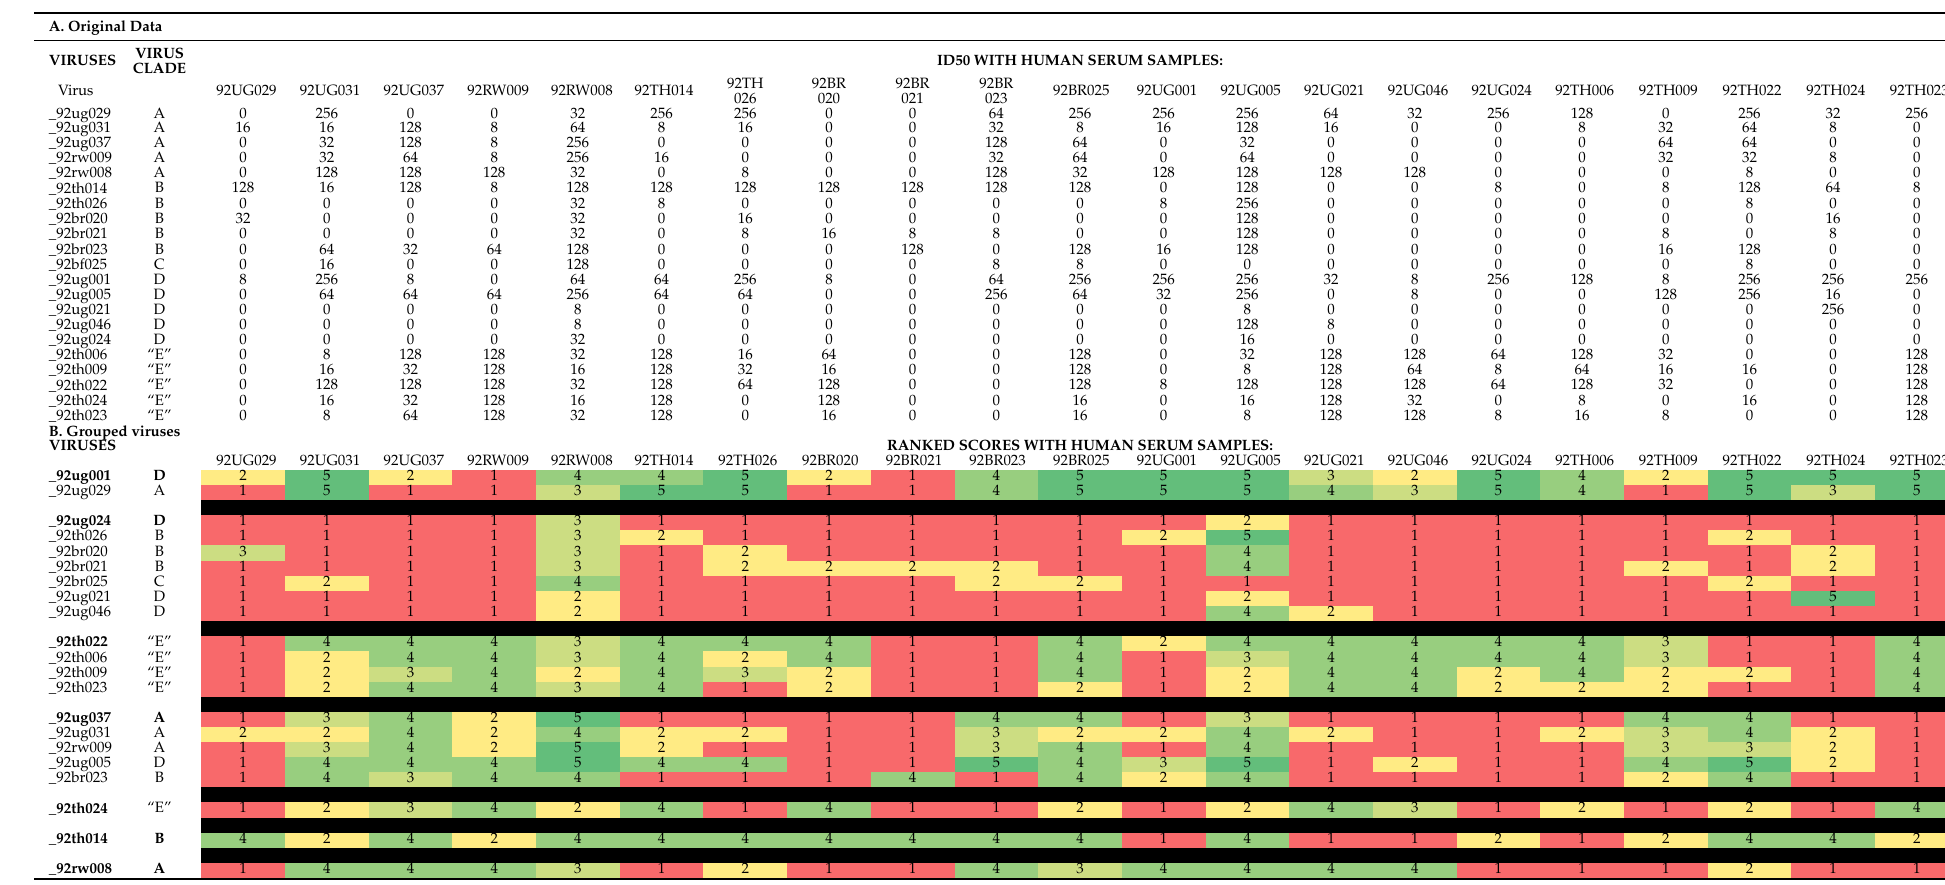
Table 1. Clustering viruses by antibody recognition patterns. ( A ) Data are from a neutralization experiment by Moore et al. [38], from which ID 50 scores were recorded. Viruses and clades/subtypes are listed in the first two columns, and sera are listed as headers of additional columns. The year and origin of virus isolation is defined in the name (TH = Thailand, UG = Uganda, RW = Rwanda, BR = Brazil). Clade/subtype “E” is now recognized as a circulating recombinant form AE [40]. Each entry is ID 50 , with ‘0‘ representing no neutralization, and ‘256’ representing an ID 50 greater than 128. ( B ) Values from Table 1A were ranked from 1 to 5, and ranks were color-coded using Microsoft Excel software (Microsoft Corporation, Remond, Washington, USA). Viruses were grouped based on similar antibody reactivity patterns using Dmax = 20 (viruses with summed differences ≤ Dmax compared to a leader were assigned to the same group). There were seven groups (separated by thick black lines) with respective leaders indicated at the top of each group in bold